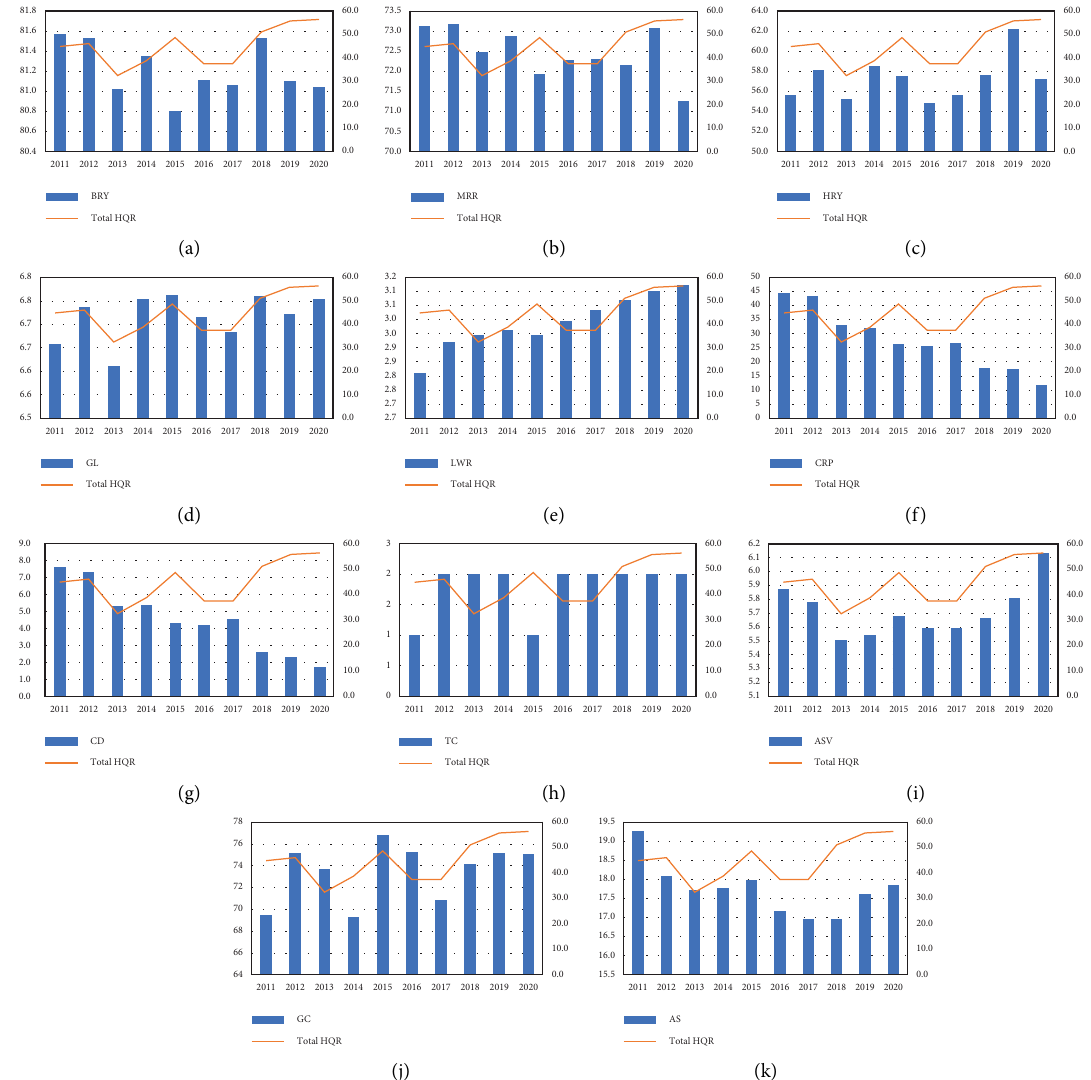
Figure 4: Annual average values of rice quality indexes and the total high-quality rate (total HQR) in southern China from 2011 to 2020. (a) BRY (brown rice yield); (b) MRR (milled rice recovery); (c) HRY (head rice yield); (d) GL (grain length); (e) LWR (length-width ratio); (f) CRP (chalky rice percentage); (g) CD (chalkiness degree); (h) TC (translucency); (i) ASV (alkali spreading value); (j) GC (gel consistency); (k) AS